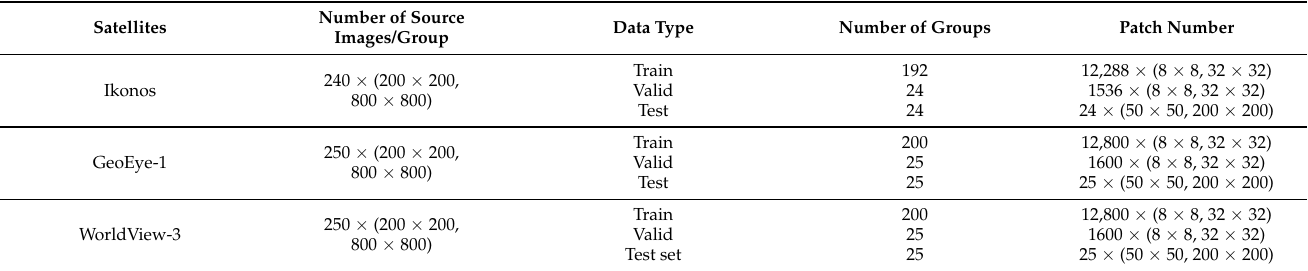
Table 2. The division of the dataset (The sizes of the LRMS and PAN